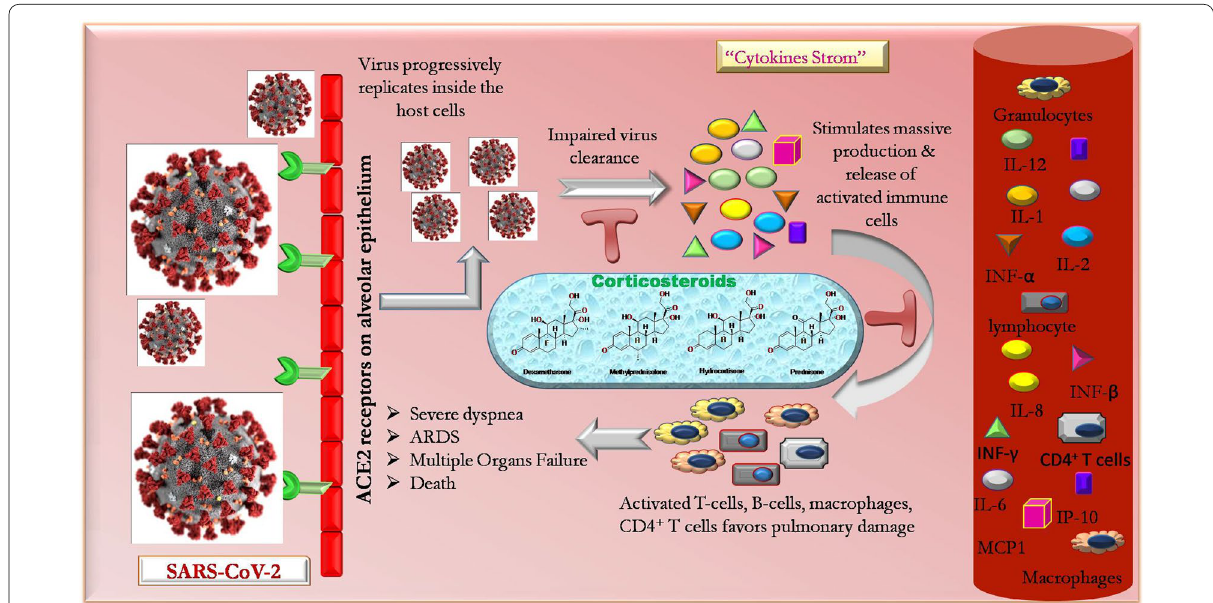
Fig. 2 Mechanism of action of corticosteroids in treatment of